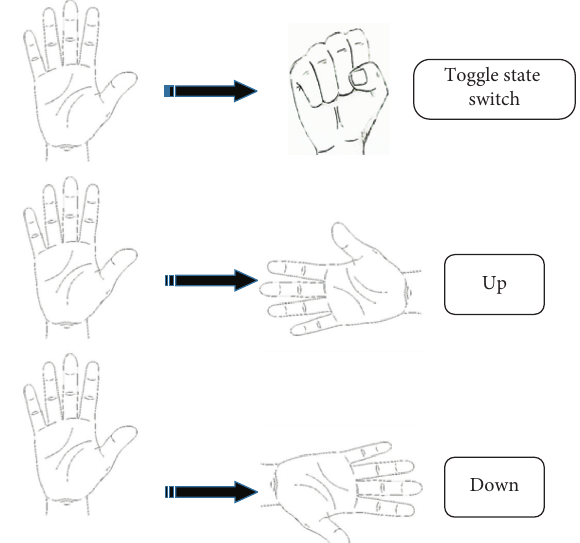
Figure 1: Gesture dataset for controlling.